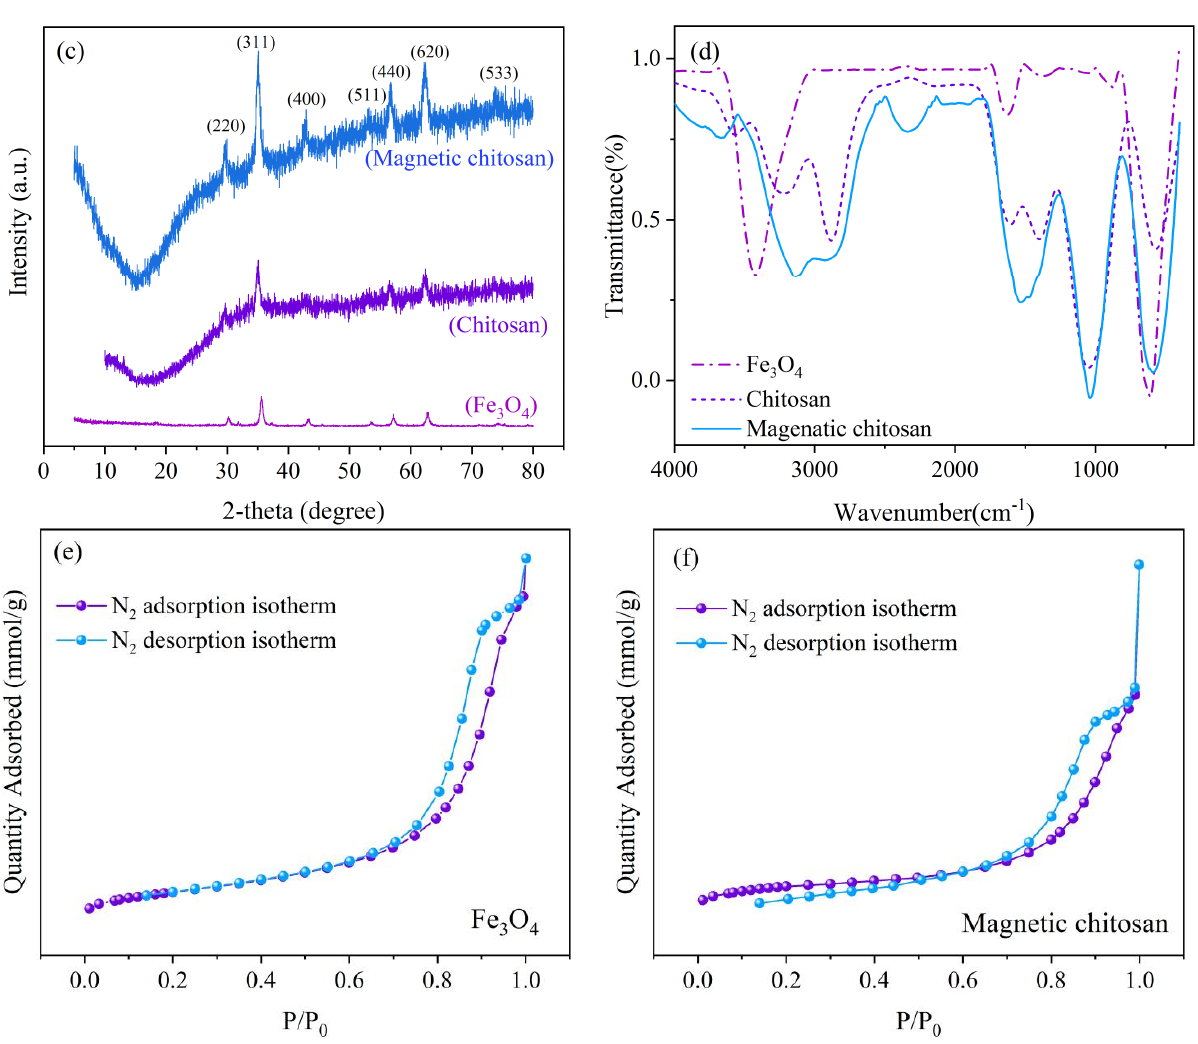
Figure 1. Images of TEM ( a ) magnetic nano-Fe 3 O 4 , ( b ) magnetic nano-chitosan), FT-IR ( c ), XRD ( d ), and N 2 adsorption/desorption isotherms ( e , f ) of magnetic nano-Fe 3 O 4 and magnetic nano-chitosan.